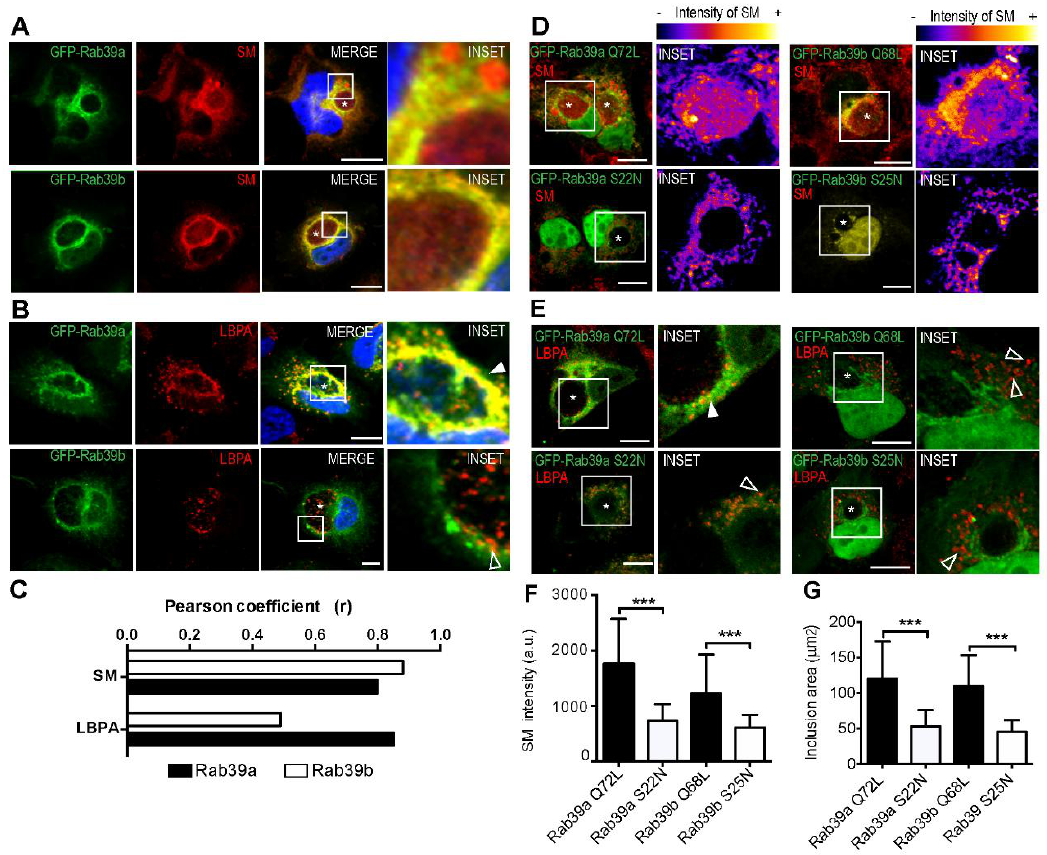
Figure 5. Rab39-controlled lipid transport in CT-infected cells. ( A – C ) Cells overexpressing GFP-Rab39aWT ( top ) and Rab39bWT ( bottom ) were infected with CT for 24 h (MOI 1). Asterisks point out chlamydial inclusions. ( A ) Before fixation, cells were incubated with BODIPY-Tr-Ceramide that turns into sphingomyelin (SM) at the Golgi apparatus. ( B ) Cells were fixed and incubated with anti-LBPA antibodies to detect lysobisphosphatidic acid. White arrowhead points out the colocalization between LBPA and Rab39a, and open arrowheads show LBPA-containing vesicle that do not bear Rab39b mark. Images are representative of three independent experiments performed in duplicates. Scale bars represent 10 µ m. ( C ) Colocalization index of Rab39 isoforms and SM or LBPA in CT-infected cells. Pearson coefficients (r) were calculated with ImageJ software by the analysis of 30 cells of each experimental condition. ( D – G ) Cells overexpressing the positive mutants GFP-Rab39aQ72L or GFP-Rab39bQ68L, or the negative mutants Rab39aS22N or Rab39bS25N were infected with CT for 24 h (MOI 1). Asterisks point out chlamydial inclusions. ( D ) Infected cells were incubated with BODIPY-Tr-Ceramide to label sphingomyelin (SM) or ( E ) anti-LBPA antibodies to detect lysobisphosphatidic acid. Images are representative of two independent experiments. Scale bars represent 10 µ m. ( D ) Intensity of fluorescent SM within and at the surroundings of chlamydial inclusions. In color scale, blue indicates the lowest amount of SM whereas yellow corresponds to the highest amount of SM. ( E ) Colocalization between LBPA and Rab39aQ72L is shown with a filled arrowhead, while open arrowheads show LBPA-containing vesicles without Rab39 labeling. ( F ) Bar graph represents the fluorescence intensity of the red labeling (SM) inside of the inclusions quantified by confocal microscopy and expressed as arbitrary units. Data were obtained from two independent experiments ( n = 30, *** p <0.001, Student t test). ( G ) Bars show the area of chlamydial inclusions, measured by confocal microscopy. Data are representative of two independent experiments ( n = 30, *** p < 0.001, Student t